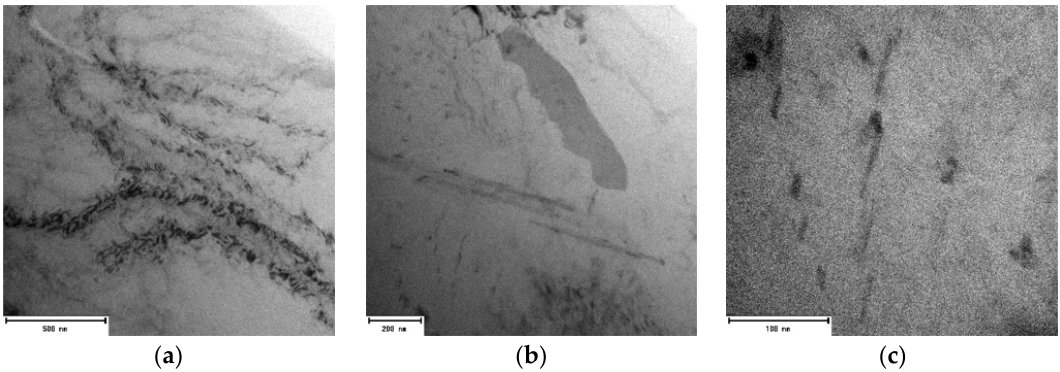
Figure 14. Substructure of 90–10 alloy after natural aging, TEM; ( a ) Overview ( b ) Detailed view